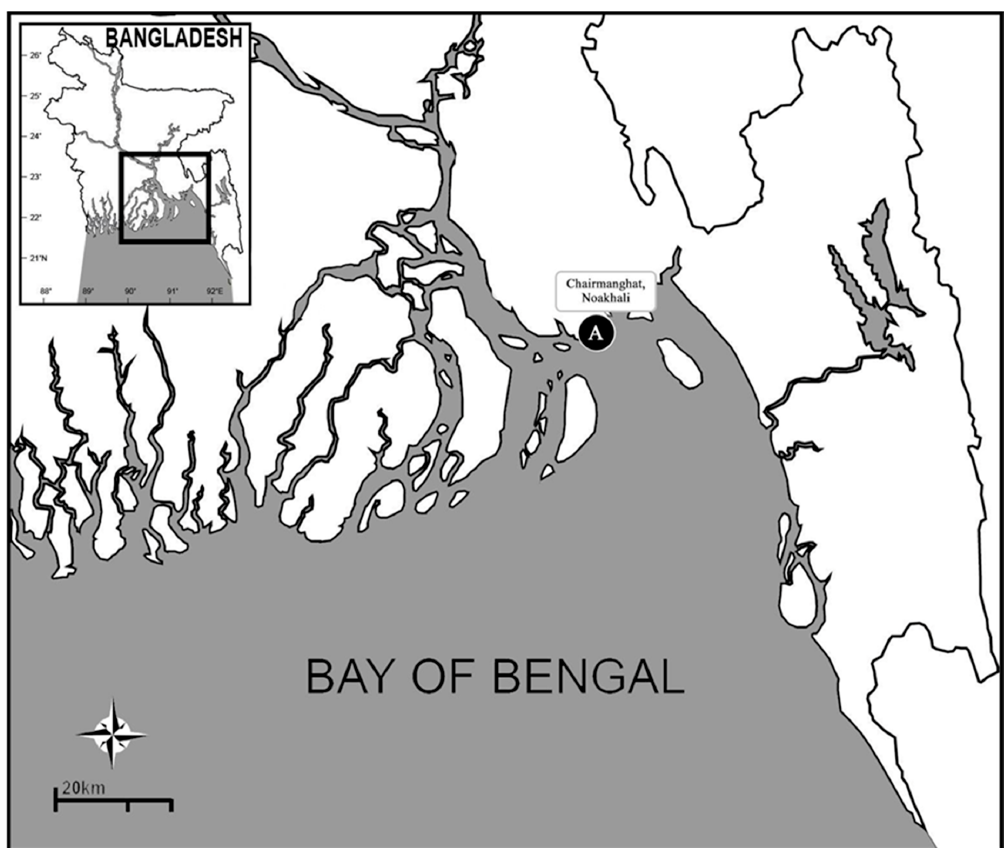
Figure 1. Map showing the collection area (A). Source: [17].